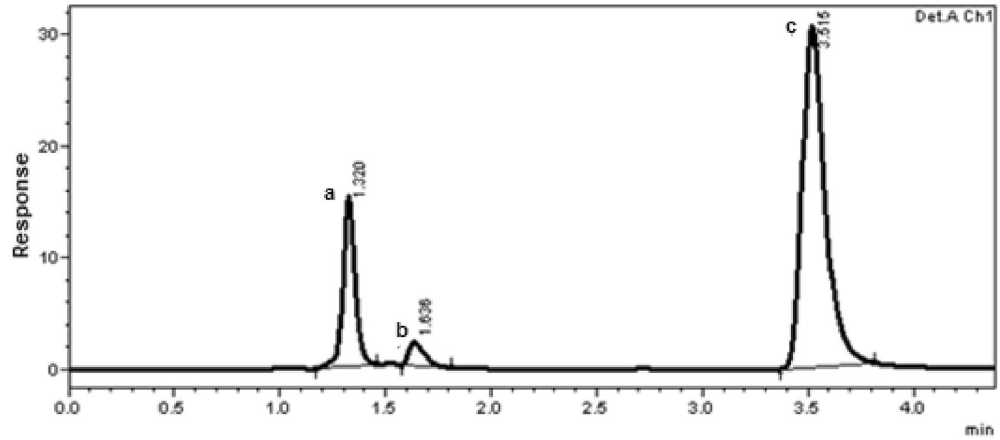
Figure 2. Typical chromatogram of laboratory prepared mixture of the studied components under the described chromatographic conditions. ( a ) PRN (0.5 μg/mL), ( b ) FLZ (5.0 μg/mL) and ( c ) MOX (5.0